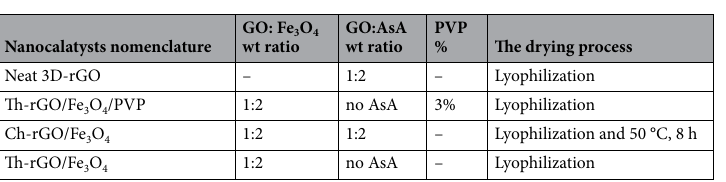
Table 1. Nomenclature of 3D materials and the conditions for their